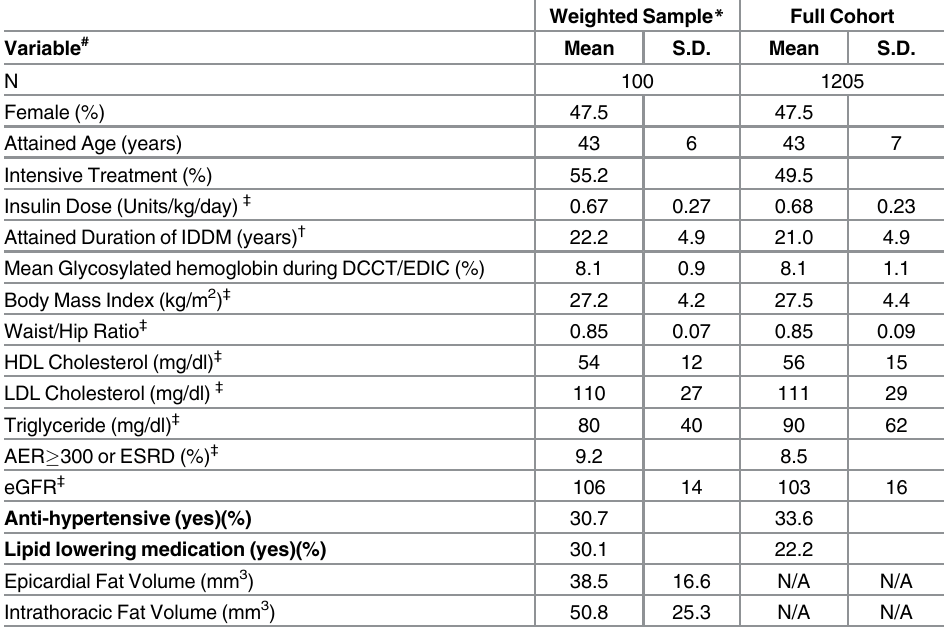
Table 1. Similar Clinical Characteristics for Weighted Sample and the Full